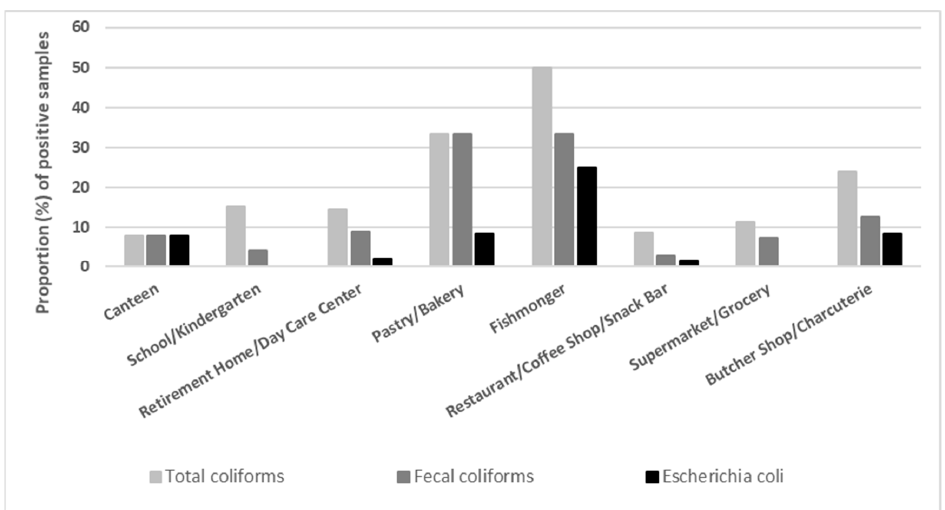
Figure 1. Proportion of positive samples for each group of microorganisms assessed in samples taken from kitchen utensils/crockery.